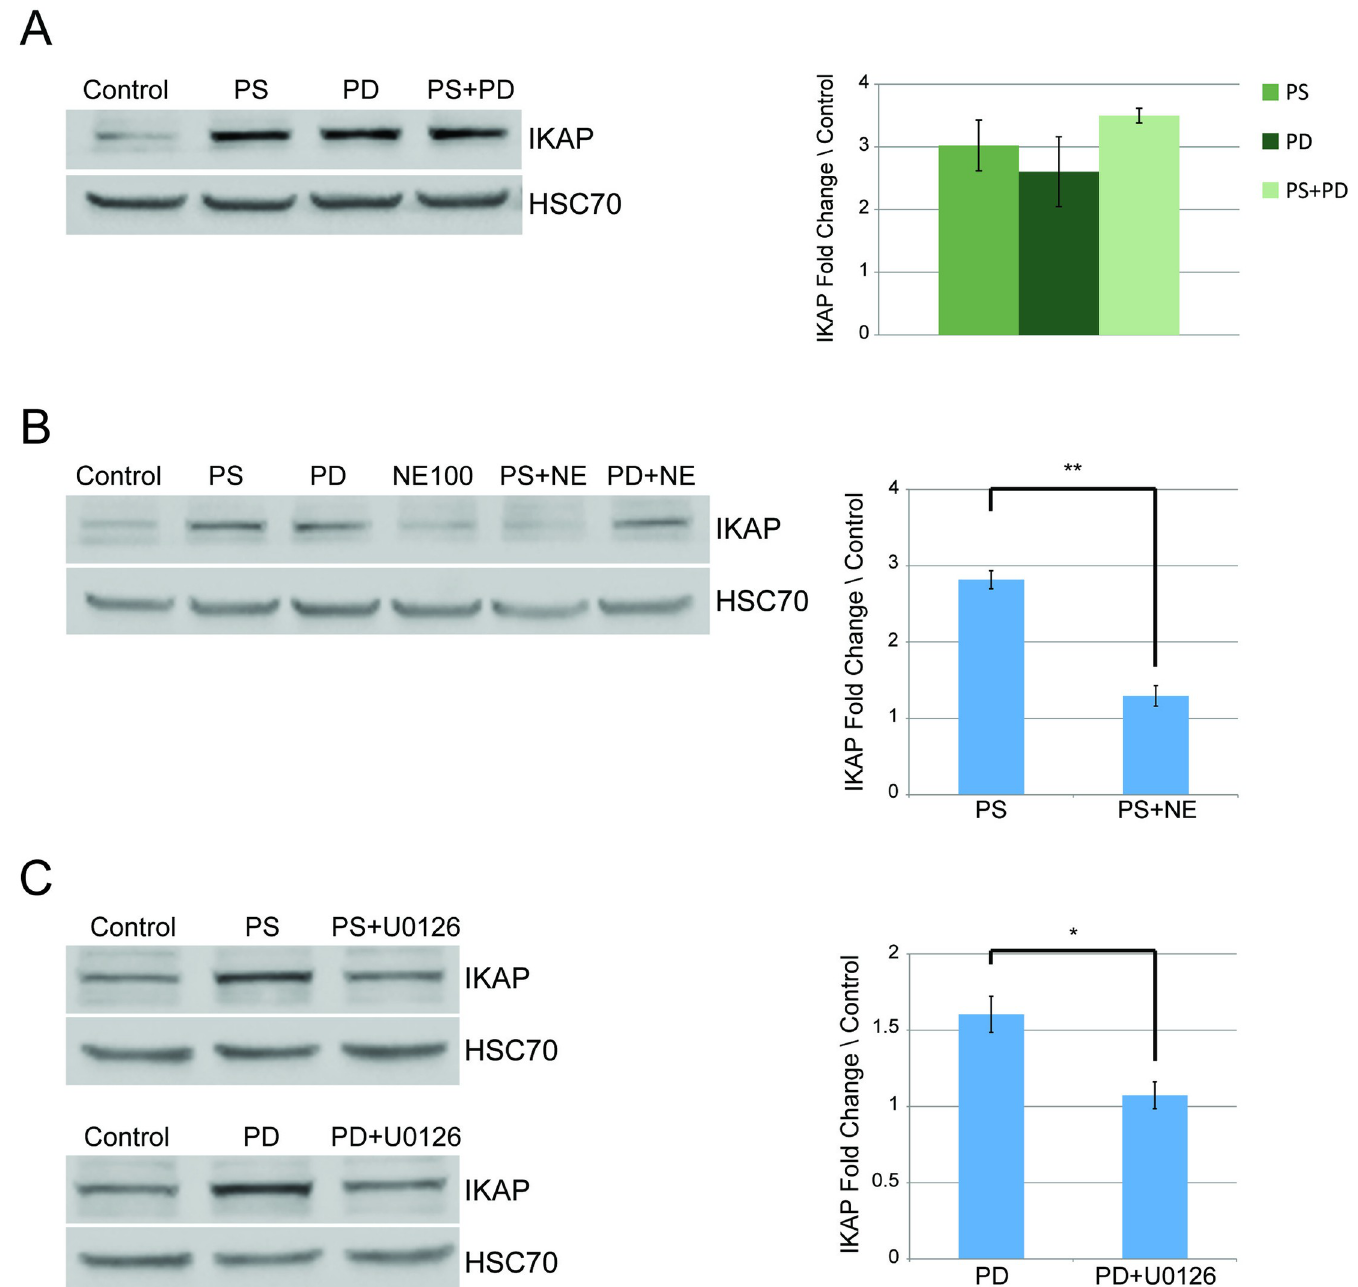
Fig 4. Phosphatidylserine and pridopidine increase IKAP levels in FD cells through the same mechanism. (A) FD cells were treated either with 50 μ g/ml of PS or 500 nM of pridopidine or the combination of both drugs. Proteins were extracted and analyzed after 7 days. Left panel: Western blot of extracted proteins analyzed using anti-IKAP antibody. Right panel: IKAP fold change levels normalized to HSC70 and relative to control (vehicle only). (B) Left panel: Western blotting with anti-IKAP antibody of lysates of FD cells treated with 50 μ g/ml PS, 500 nM of pridopidine, 2 μ M sigma-1 receptor inhibitor NE-100, or indicated combinations. Right panel: IKAP fold change levels normalized to HSC70 and relative to control. (C) Left panel: Western blotting using anti-IKAP antibody of lysates of FD cells treated with 50 μ g/ml PS or 500 nM pridopidine with or without 2 μ M MAPK inhibitor U0126. Right panel: IKAP fold change levels normalized to HSC70 and relative to control. All quantifications were done using FusionCapt software. Asterisks denote statistically significant differences ( � P � 0.05 and �� P � 0.01) relative to control (vehicle only treated cells); Student’s t -test.